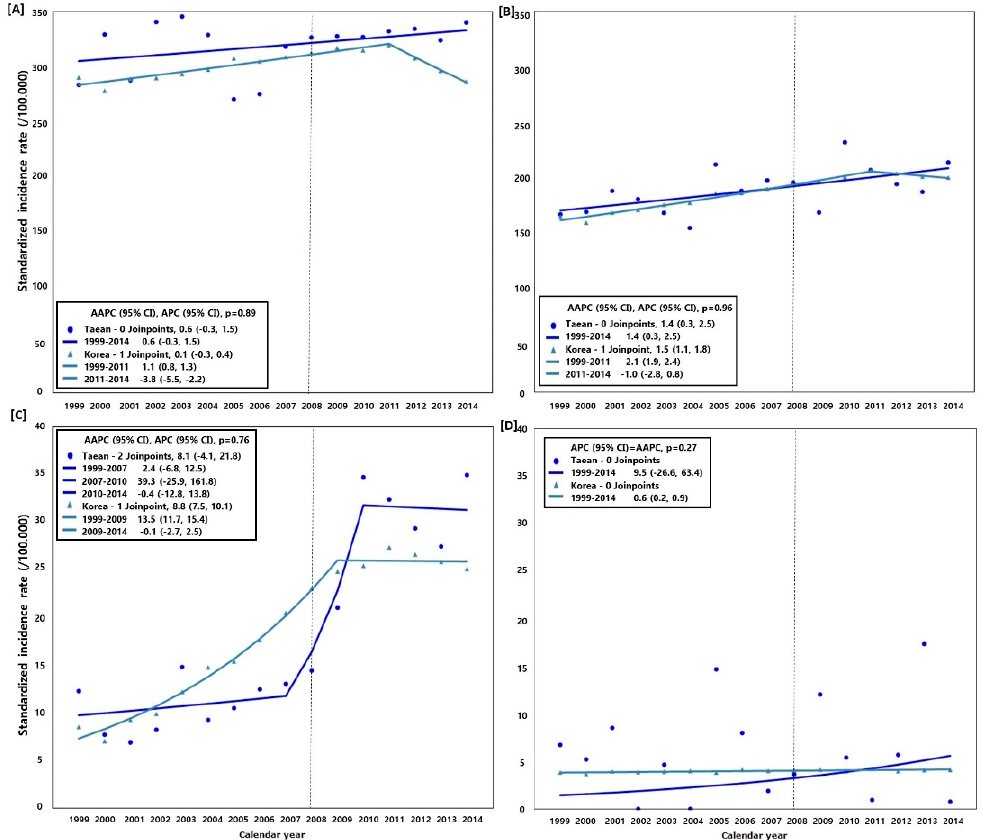
Figure 2. Comparison of the cancer incidence rate and average annual percent change (AAPC) between Taean and the whole of Korea, 1999 − 2014; Model selection and p -value estimated using the Monte Carlo Permutation method. ( A ) All cancers (C00 − C96) excluding thyroid cancer (C73) in men; ( B ) All cancers (C00 − C96) excluding thyroid cancer (C73) in women; ( C ) Prostate cancer (C61) in men; and ( D ) Leukemia (C91 − C95) in women. The Hebei Spirit oil spill (HSOS) occurred in 7 December